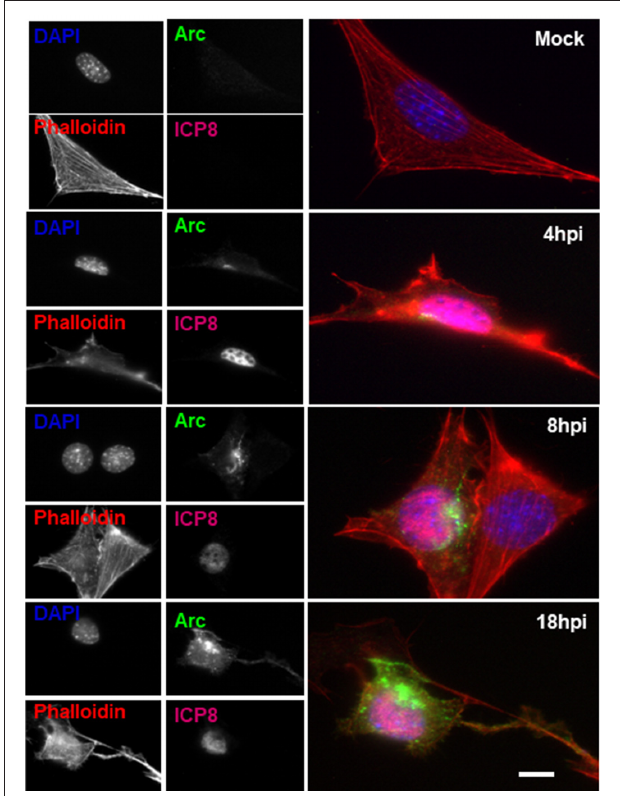
FIGURE 5 | Altered Arc protein distribution during HSV-1 neuronal infection. Untreated (mock) or HSV-1-infected HT22 cells (MOI = 10) during 4, 8 or 18 hpi were stained with specific antibodies to Arc or to ICP8 followed by secondary antibodies coupled to Alexa Fluor 488 and 647 dyes, respectively. Phalloidin staining was coupled with Alexa Fluor 594 dye and Nuclei stained with DAPI. Scale bar corresponds to 10 µ m. Magnification 630 × . The results shown are representative of three independent experiments.